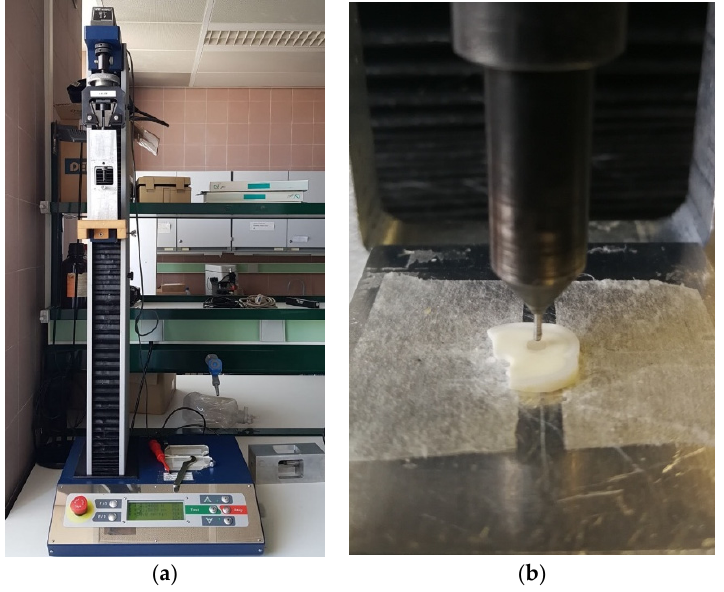
Figure 2. ( a ) Hounsfield Universal Test Equipment ® (Croydon, England); ( b ) cylindrical steel punch centered on the specimen in the Universal Test Machine.